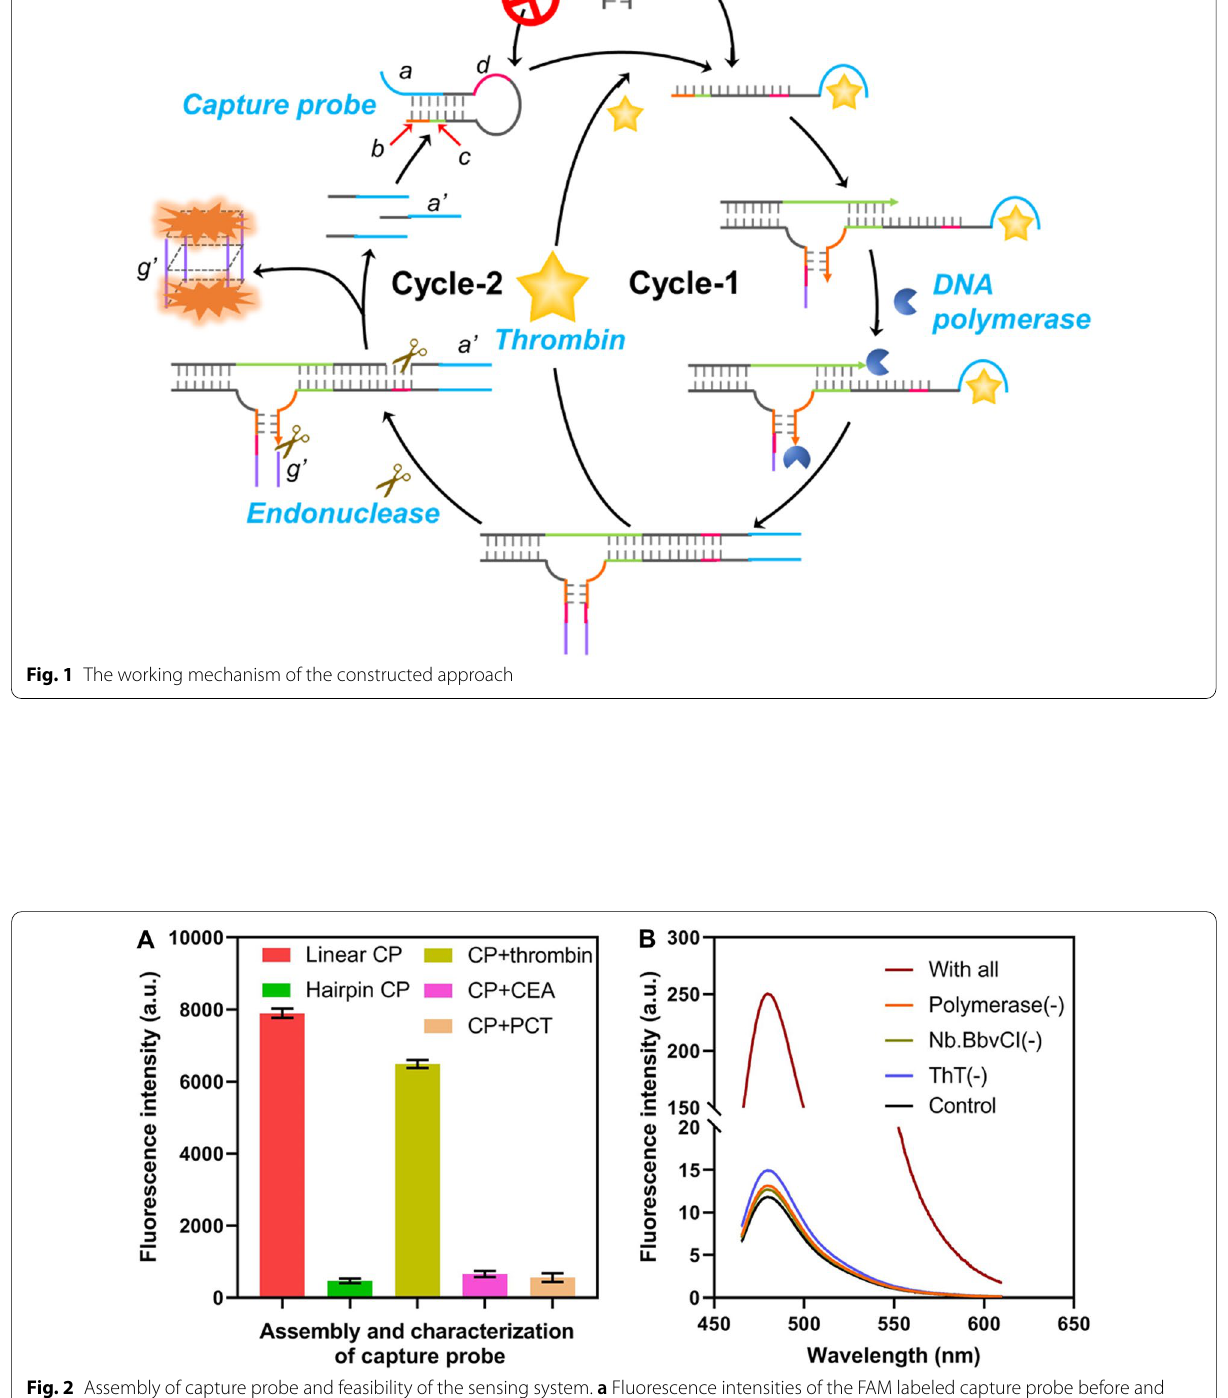
Fig. 2 Assembly of capture probe and feasibility of the sensing system. a Fluorescence intensities of the FAM labeled capture probe before and after assembly; b fluorescent spectrum of the approach when DNA polymerase, Nb.BbvCI, and ThT existed or not. Control refers to the result when thrombin was absent in the